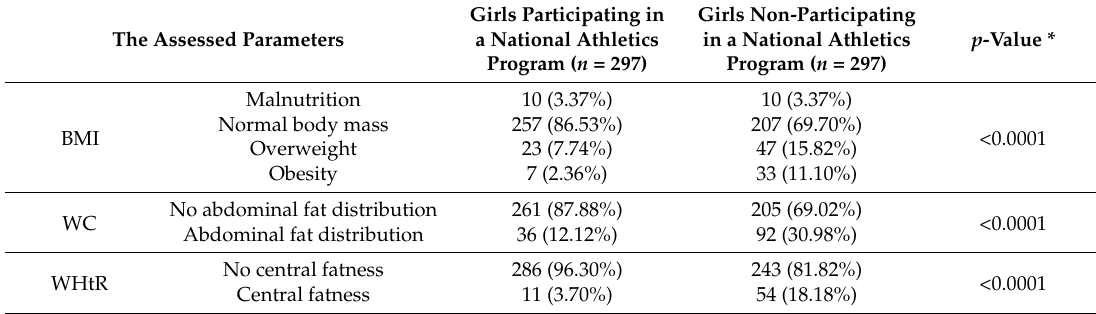
Table 5. The assessment of body mass and abdominal fat distribution in group of girls participating in a national athletics program and pair-matched control group of